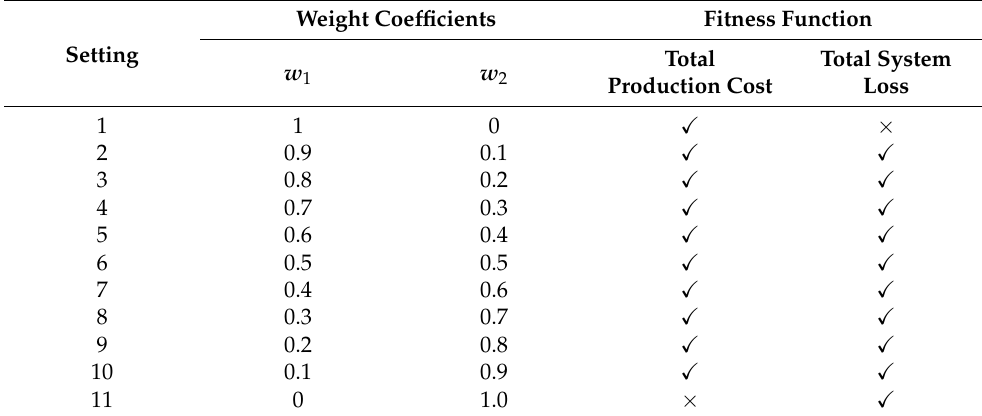
Table 1. Weight coefficients values for two objective functions (total production cost and total system loss).